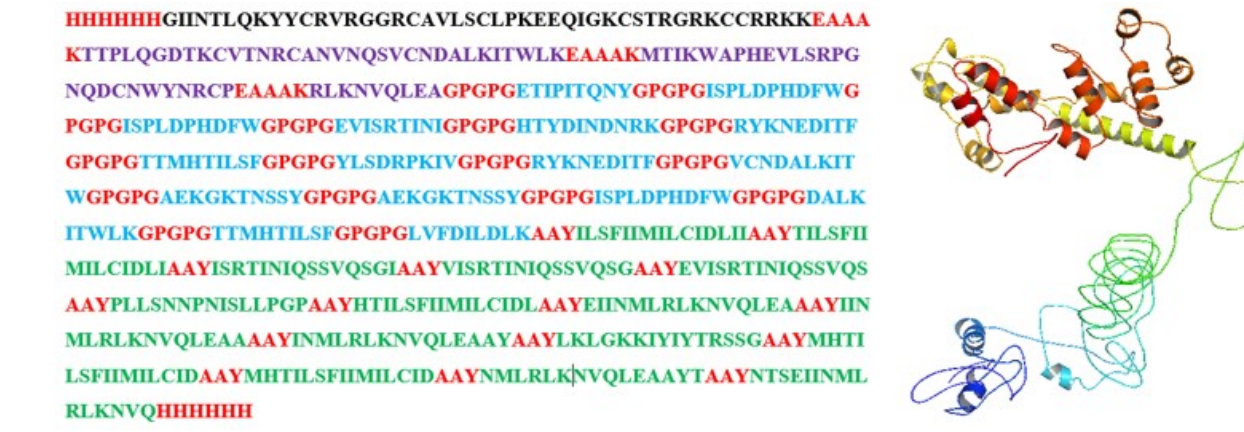
Figure 3. Prepared vaccine construct with the His-tag and linkers in red, adjuvant in black, B-cell epitopes in purple, MHC-I epitopes in blue, and MHC-II epitopes in green and its 3D model.